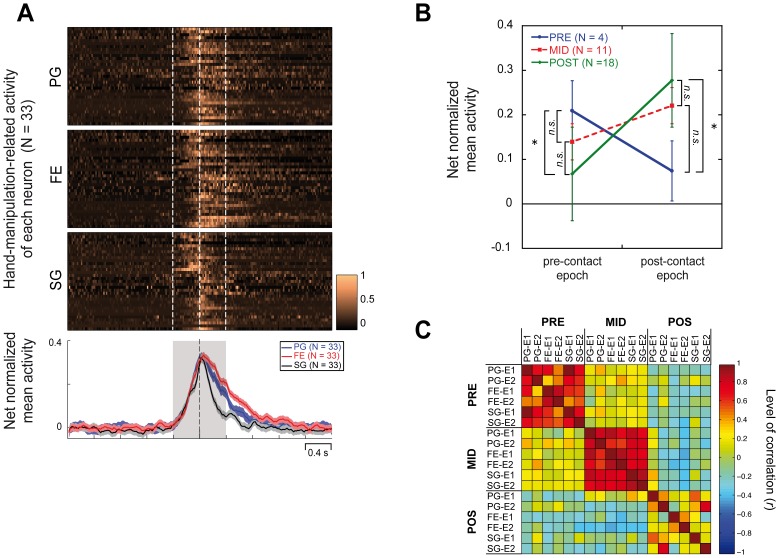
Population analysis of hand-manipulation-related neurons.(A) Net normalized activity of 33 neurons for each grip (upper illustration). Temporal profile of the mean normalized activity of the whole neuronal population for each grip (bottom illustration). Raster and histograms are aligned at the monkey’s hand-target contact. The gray shaded regions and the area between white dashed lines indicate the two hand-manipulation epochs (pre-contact and post-contact). (B) Mean net normalized response in Pre-contact, Middle and Post-contact-selective type of neurons in the pre- and post-contact epochs. Bars indicate ± SEM, *p<.01. (C) Correlation analysis among mean net normalized responses to each of the 3 grips (PG, FE and SG) and 2 epochs (E1, E2) in the 3 types (PRE, MID and POS). Color code indicates correlation value (r) between all possible pair of responses.